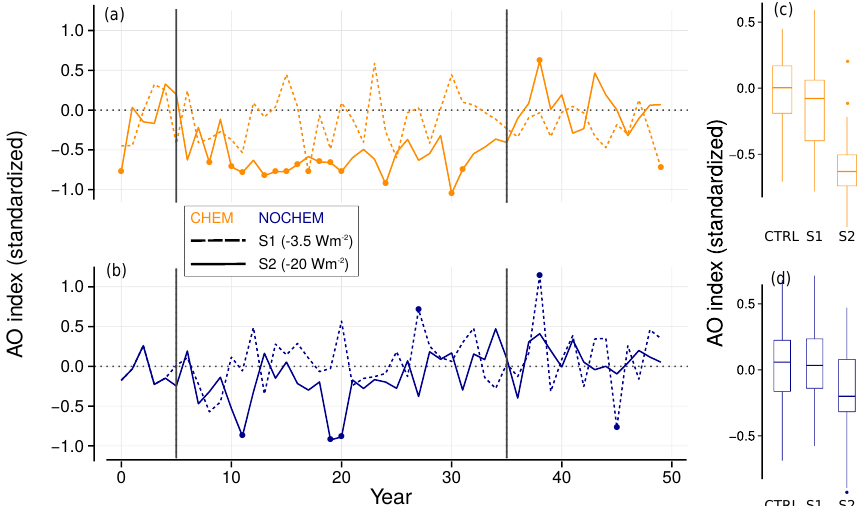
Figure 7. (a, b) Ensemble mean AO index (standardized and reversed sea level pressure difference between 45 and 65 ◦ N) per winter (November–March). Dots indicate winters with significant differences to the CTRL ensemble (Student t test p ≤ 0.05). (c, d) Box plot statistics for the AO index averaged over the SRR. The beginning and the end of the SRR period are indicated by vertical lines in panels (a) and (b)